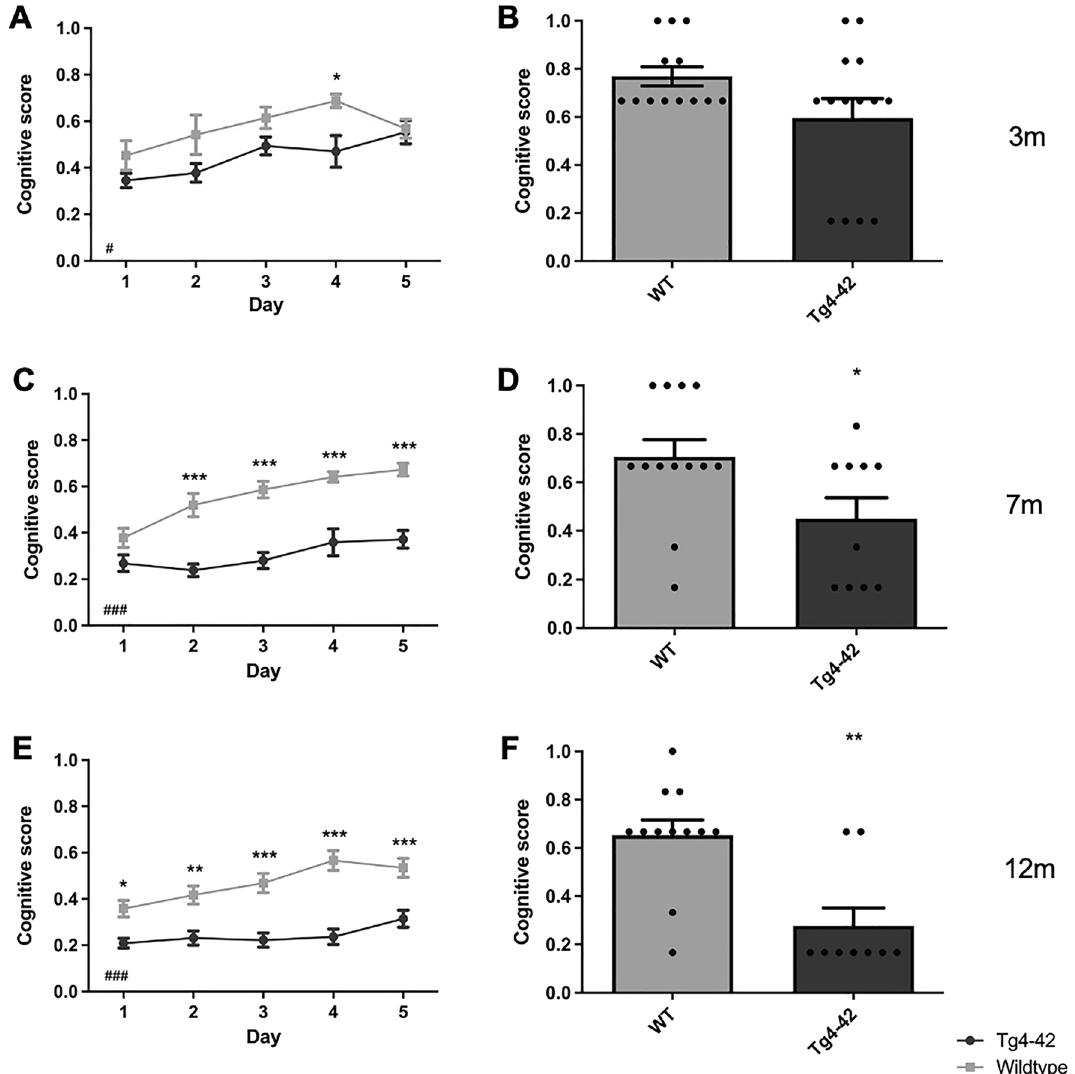
animals. During the probe trial, 3m old Tg4-42 ( B ) mice show a similar cognitive score compared to WT mice. In contrast, 7m ( D ) and 12m old Tg4-42 ( F ) exhibit significantly reduced cognitive scores in the probe trial. Two-way repeated measures analysis of variance (ANOVA) followed by Bonferroni multiple comparisons. ANOVA: # p < 0.05, ### p < 0.001; Bonferroni: * p < 0.05, ** p < 0.01, *** p < 0.001. n = 9–14. Data presented as mean ±